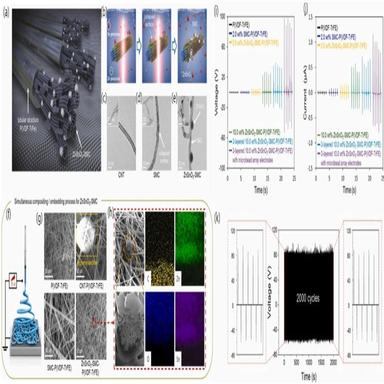
(a) Conceptual illustration showing the ZnSnO3-SMC-P(VDF-TrFE) nanofibers (NFs). (b) Schematic depiction of the ZnSnO3-SMC prepared by one-step pulsed laser ablation in liquid (PLAL) (red, silver, and white dots correspond to Sn, Zn, and ZnSnO3, respectively). (c-e) HR-TEM images showing the formation of ZnSnO3- SMC. (f) Schematic illustration of the electrospinning process used to prepare the P(VDF-TrFE)-based NFs. (g) FE-SEM images of the electrospun P(VDF-TrFE)-based NFs with various fillers, including C